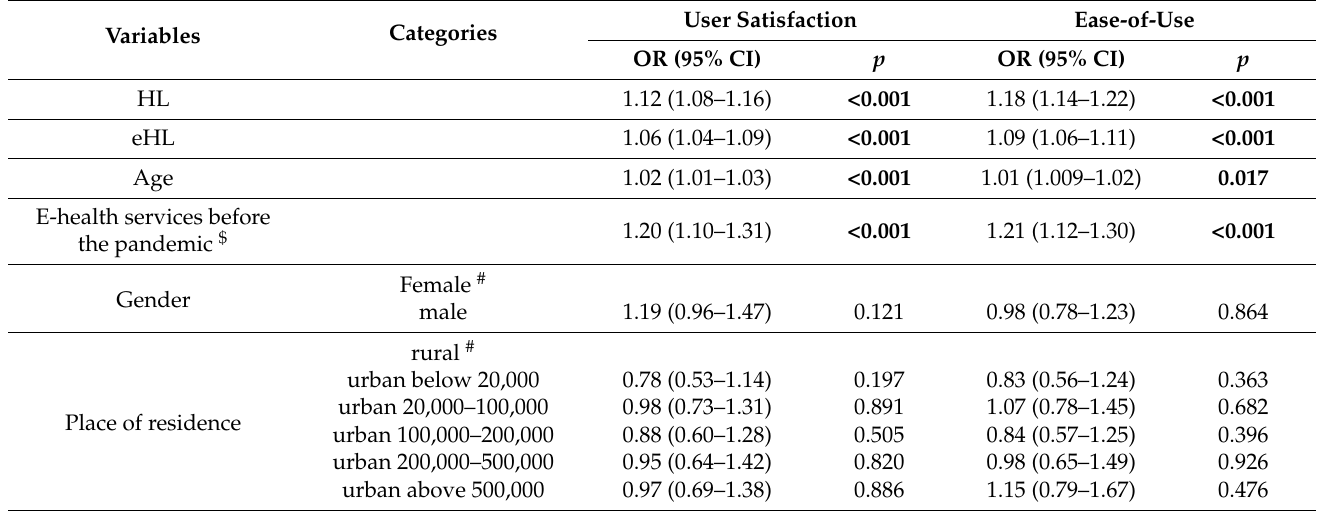
Table 4. Univariable logistic regression for user satisfaction and ease-of-use of remote physician visits during the COVID-19